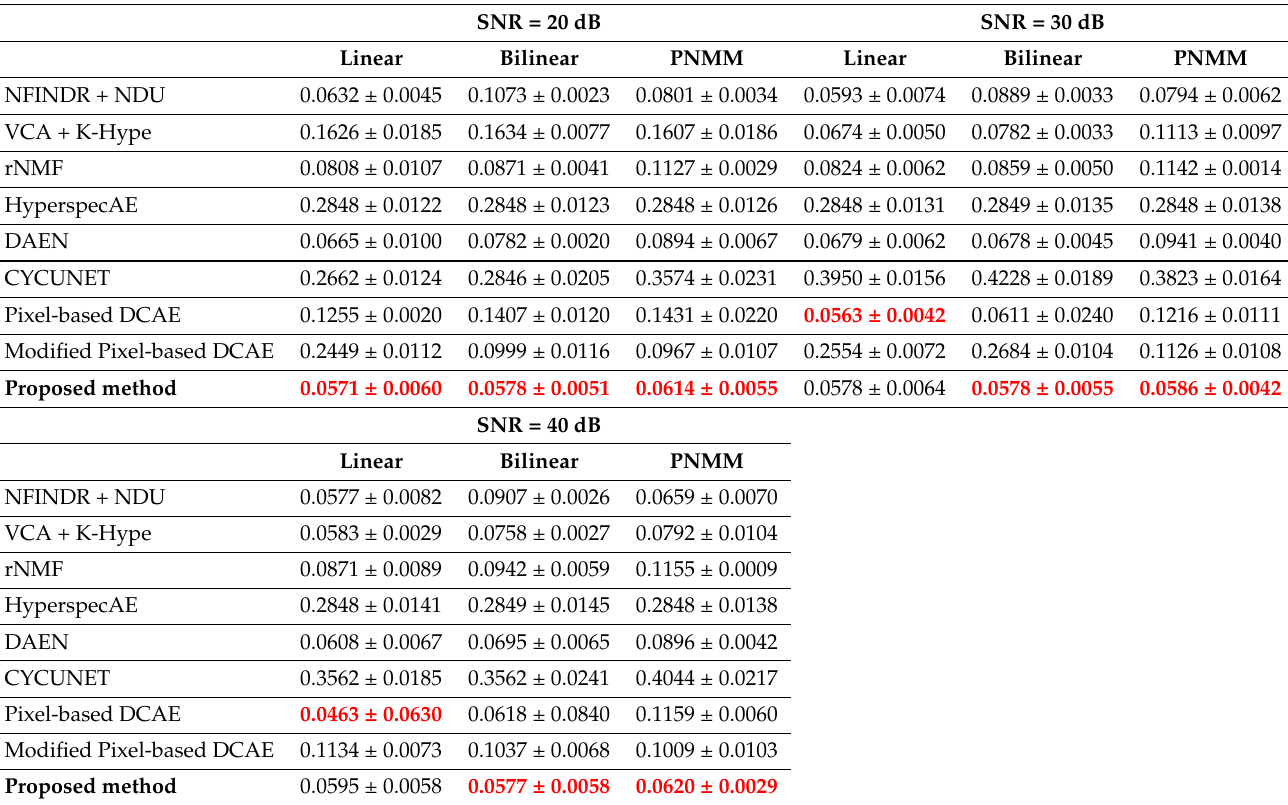
Table 3. Abundance RMSE comparison of the synthetic data (best results are highlighted in red).